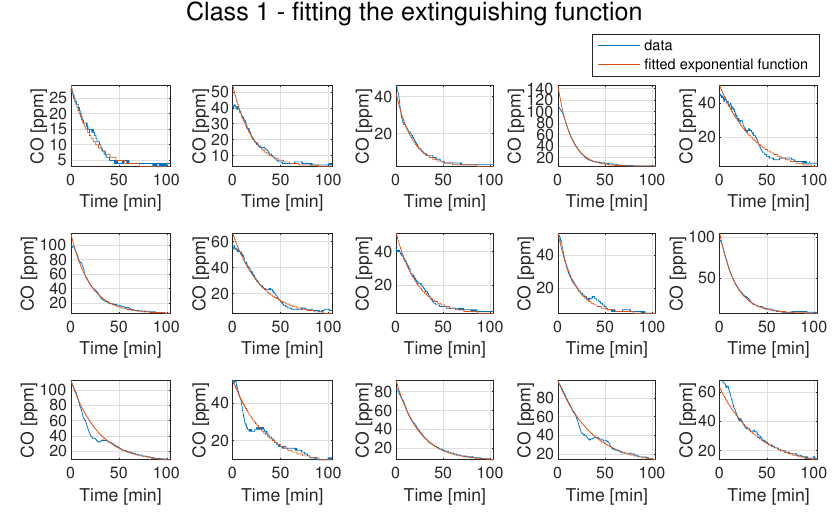
Figure A7. The results of fitting of the deterministic function to the extinguishing process—Part I.